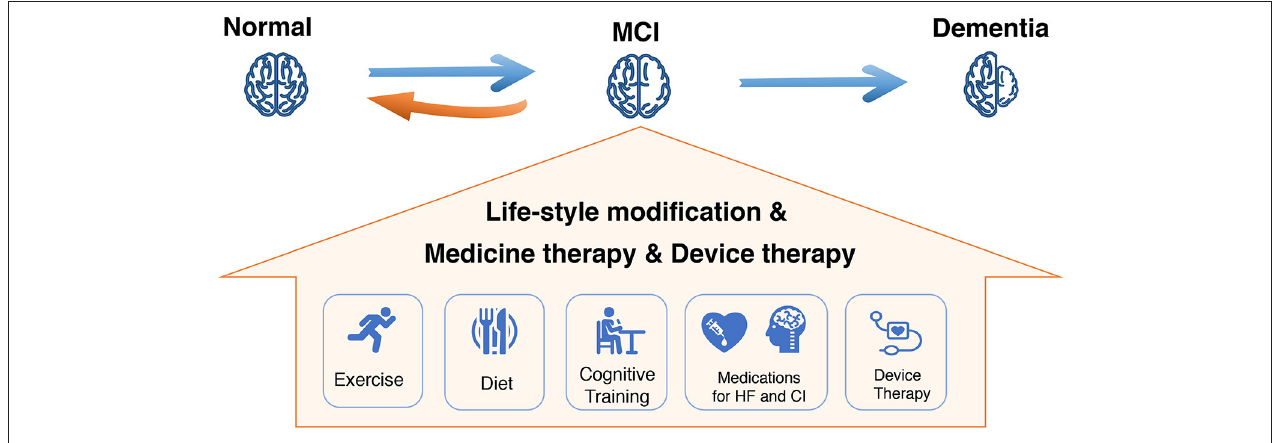
FIGURE 4 | Comprehensive management for mild CI (MCI) in HF to halt disease progression. MCI, mild cognitive impairment; HF, heart